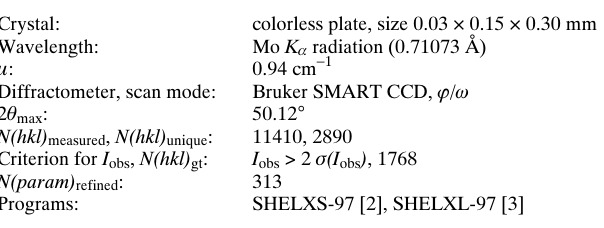
Table 1. Data collection and handling.